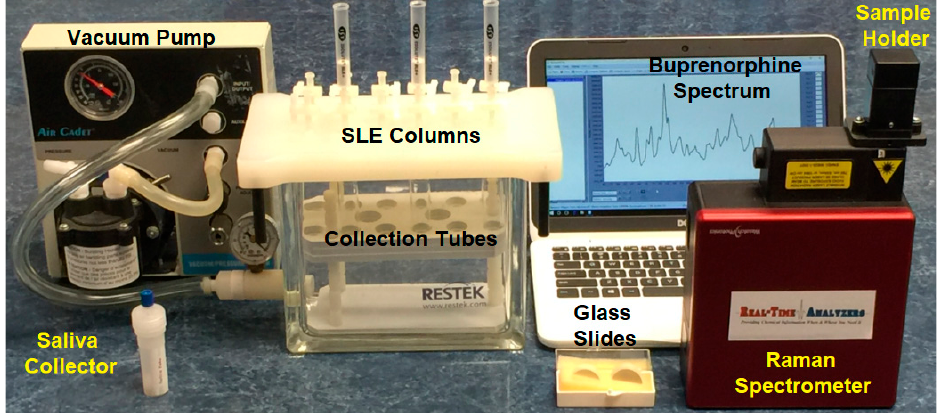
Figure 8. Photograph of the SLE-SERS-POC prototype analyzer.